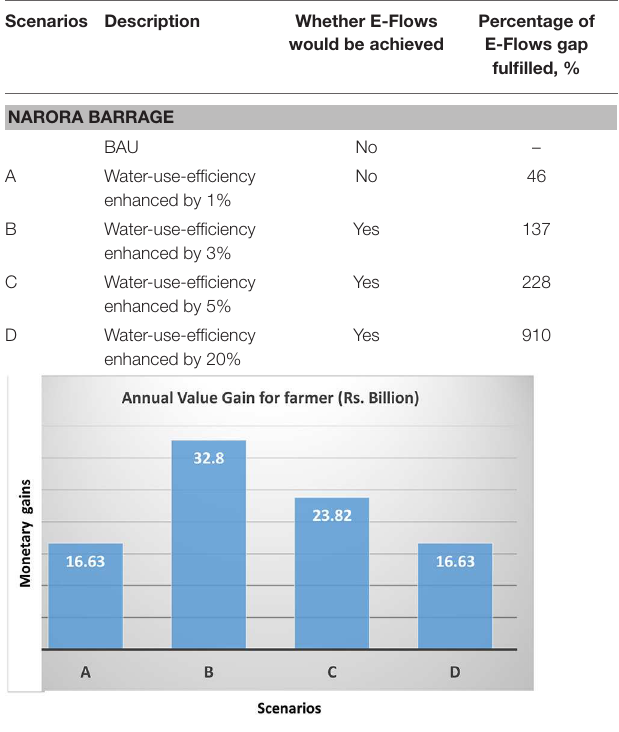
TABLE 3 | Different WUE scenarios for LGC systems for fulfillment of E-Flows in Ganga. Scenarios